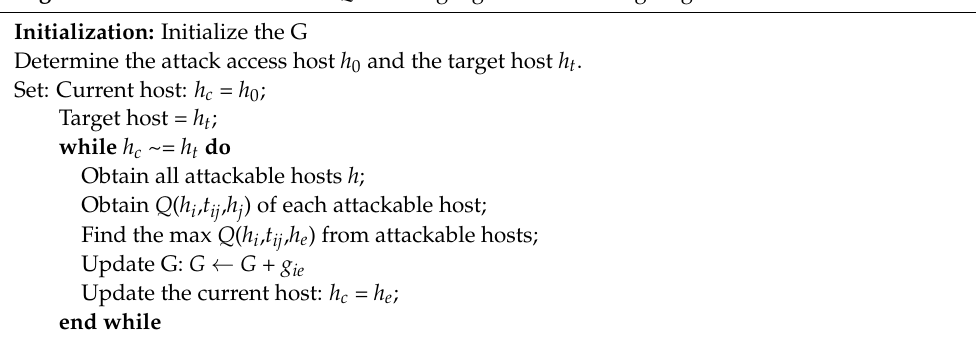
Algorithm 2 environment: FPN-Q Learning algorithm: learning stage